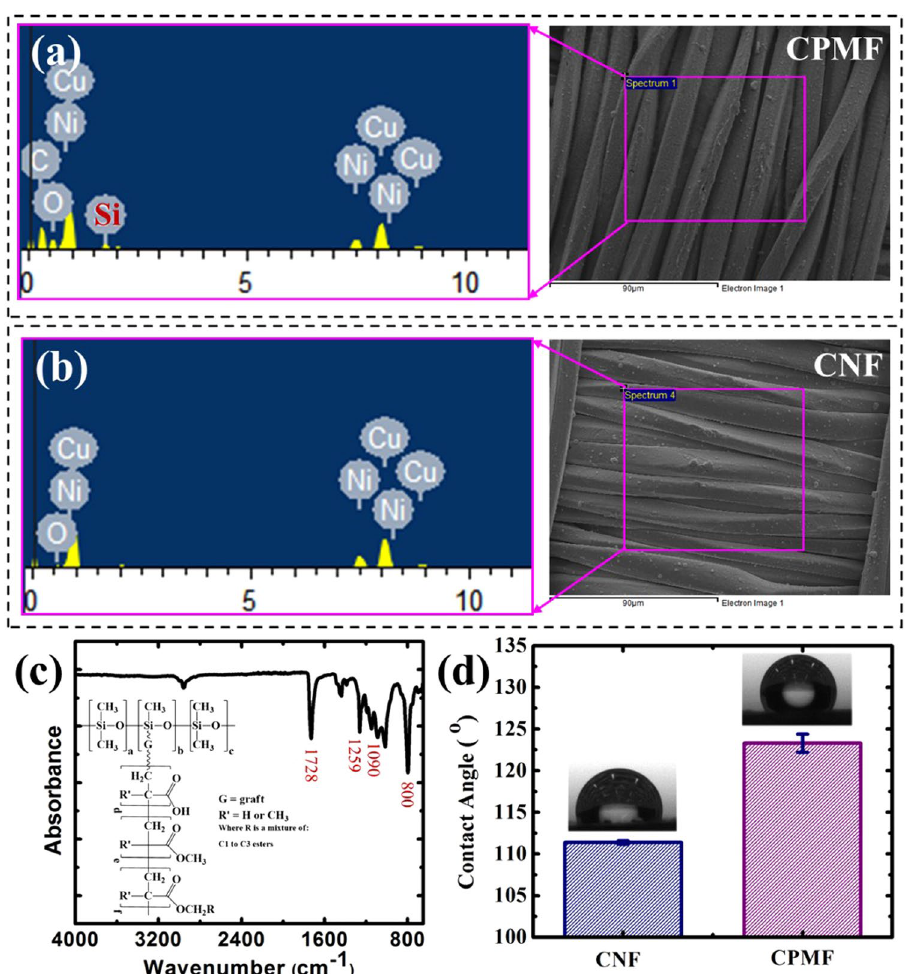
Figure 2. Typical EDX patterns of ( a ) CPMF and ( b ) CNF samples without gold coating, ( c ) FTIR spectrum and chemical structure of PDMS- g -PAs (inset), and ( d ) comparison of static contact angles of water droplets on CNF and CPMF. The insets of ( d ) are photographs of water droplets placed on CNF and CPMF,